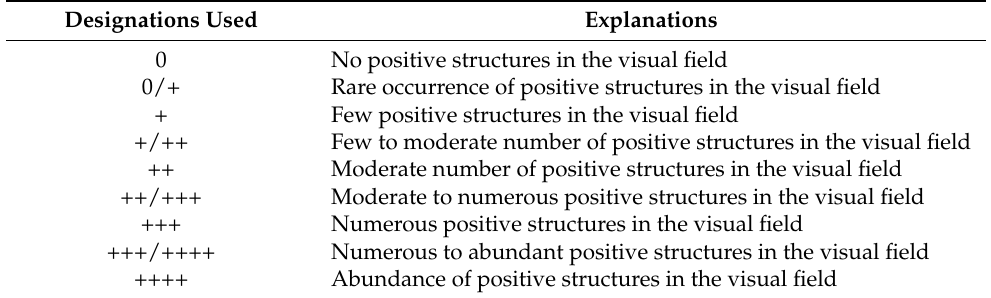
Table 1. Relative frequency designations of immunohistochemically determined gene proteins.